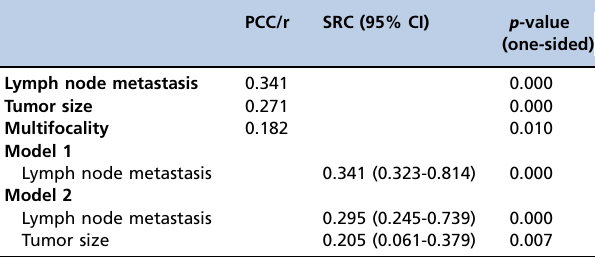
Table 3 - Multivariate analysis of the preoperative neutrophil- to-lymphocyte ratio.